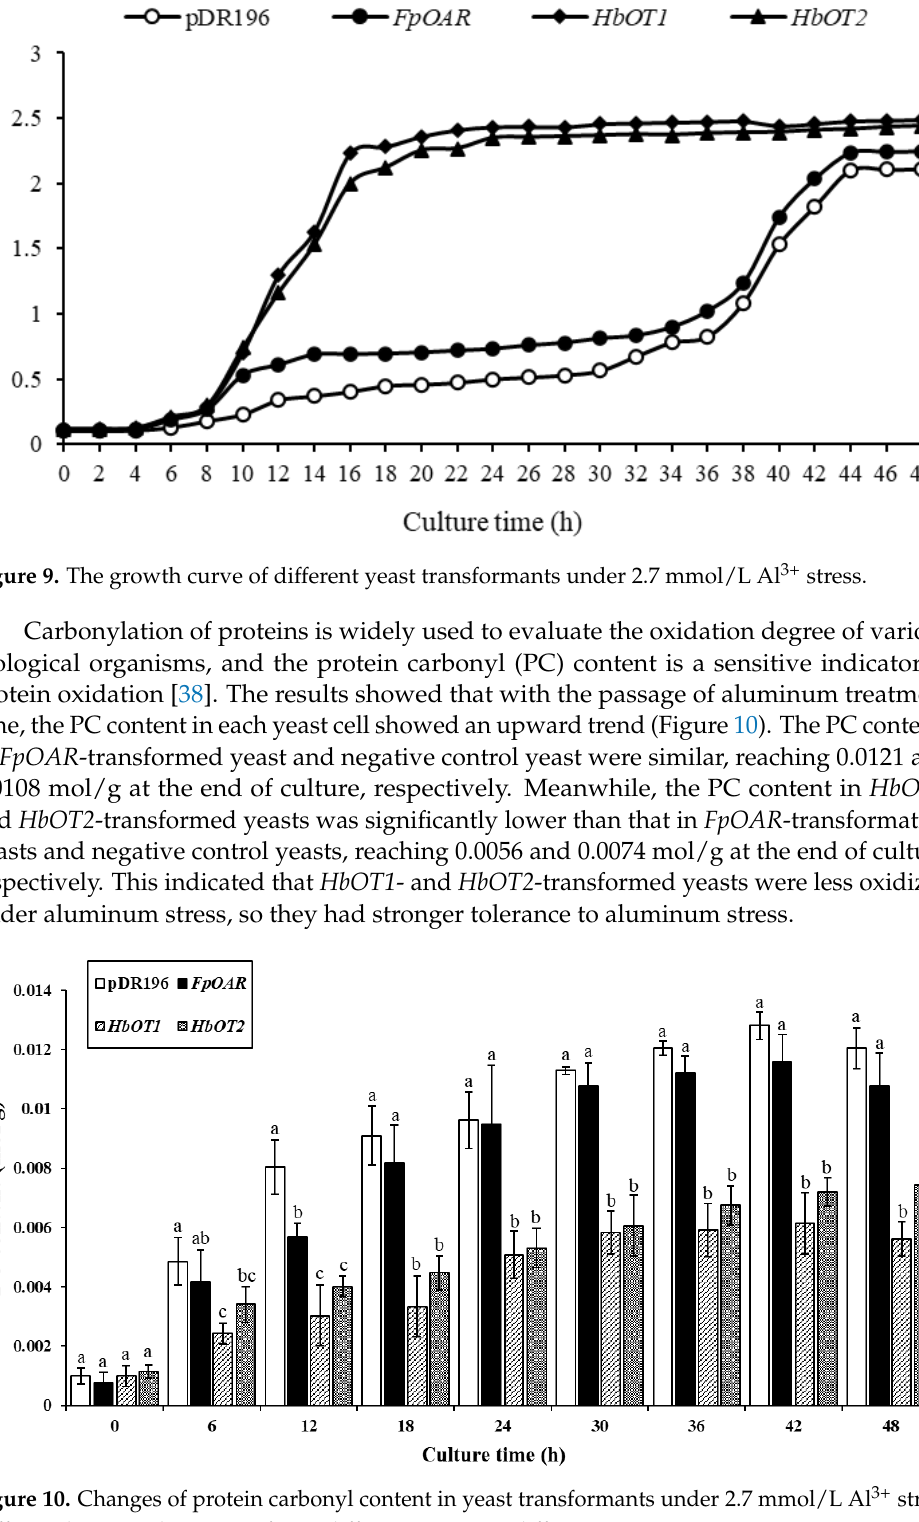
Figure 9. The growth curve of different yeast transformants under 2.7 mmol/L Al 3+ stress.